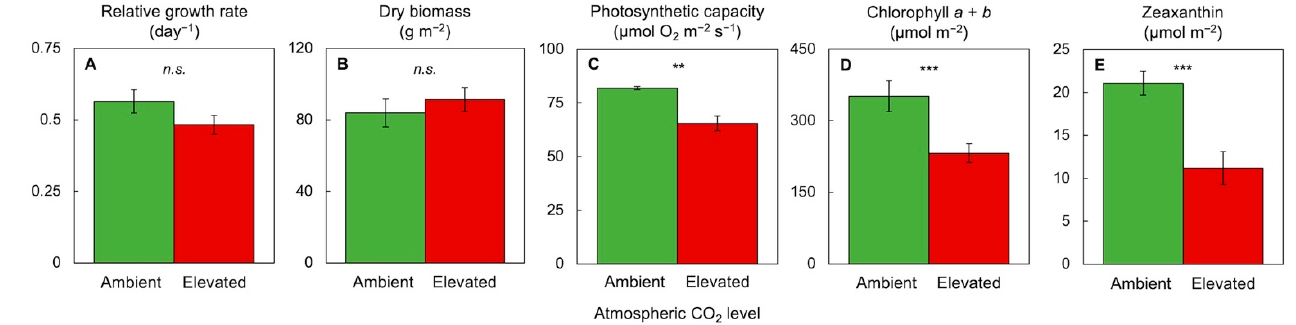
Figure 8. Effect of elevated compared to ambient atmospheric CO 2 level on ( A ) the relative growth rate (of frond area expansion) as well as ( B ) dry biomass, ( C ) photosynthetic capacity, ( D ) chlorophyll content, and ( E ) zeaxanthin content per frond area in Lemna minor . Elevated CO 2 level was 0.7%; light environment was continuous light of 700 µmol photons m − 2 s − 1 ; nutrient medium was ½ strength Schenk and Hildebrandt medium [72]. For other experimental conditions and methods, see [23]. n.s ., not significant. Asterisks indicate significant differences at p < 0.01 (**) or p < 0.001 (***).